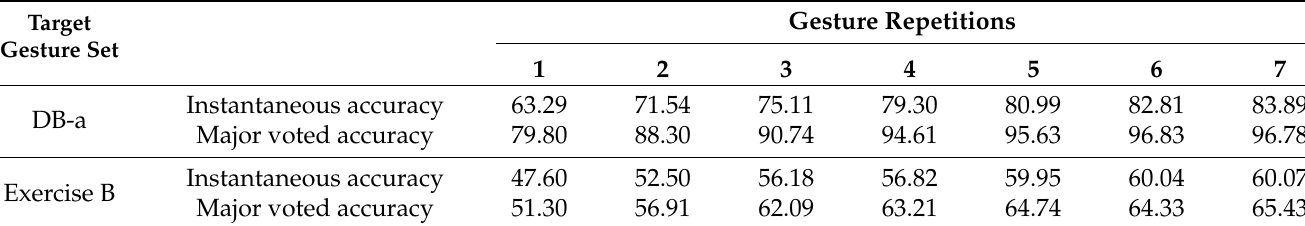
Table 4. The average instantaneous accuracy (%) and the average major voted accuracy (%) for new gesture recognition Target Gesture